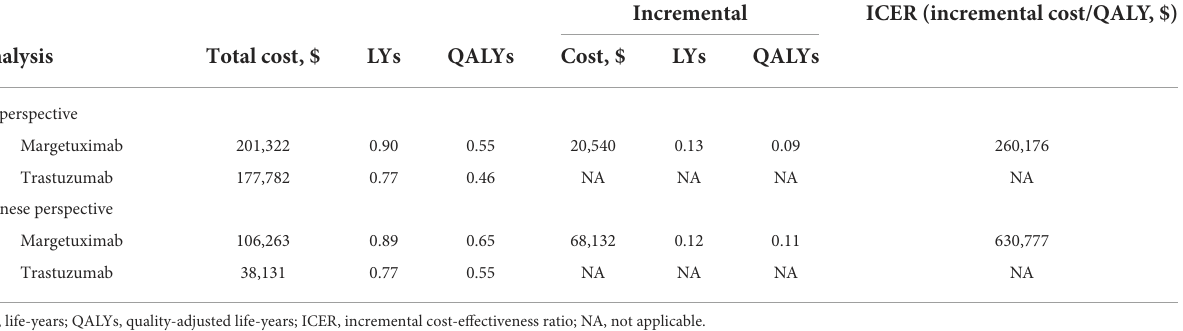
TABLE 2 Discounted incremental cost-effectiveness of margetuximab vs. trastuzumab.